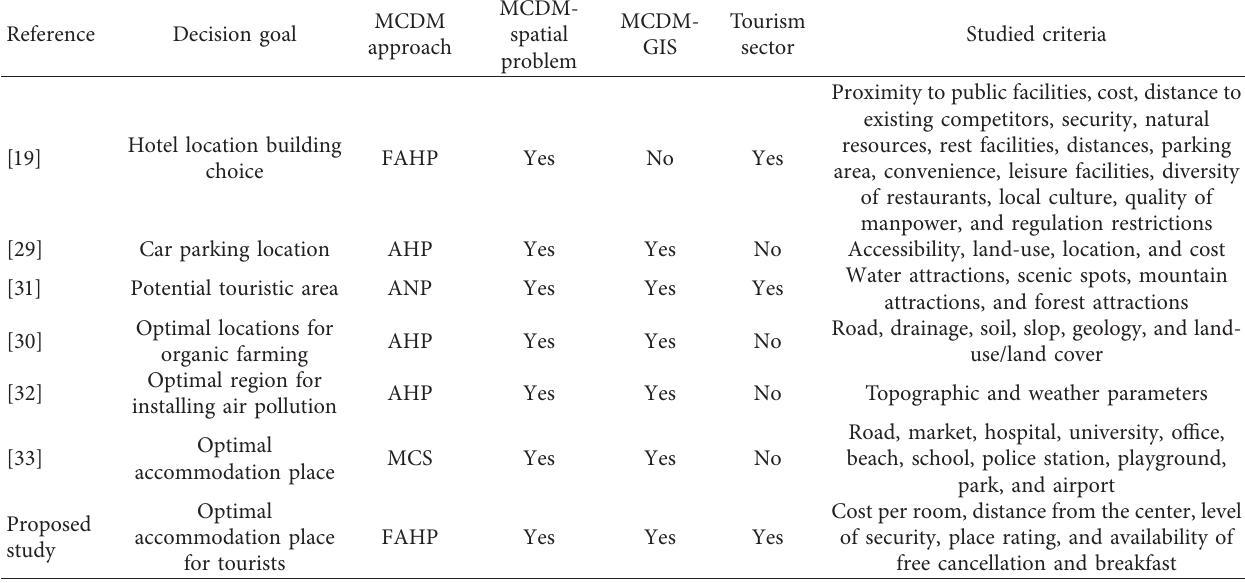
Table 1: Comparison of the applied methodology in this study and previous